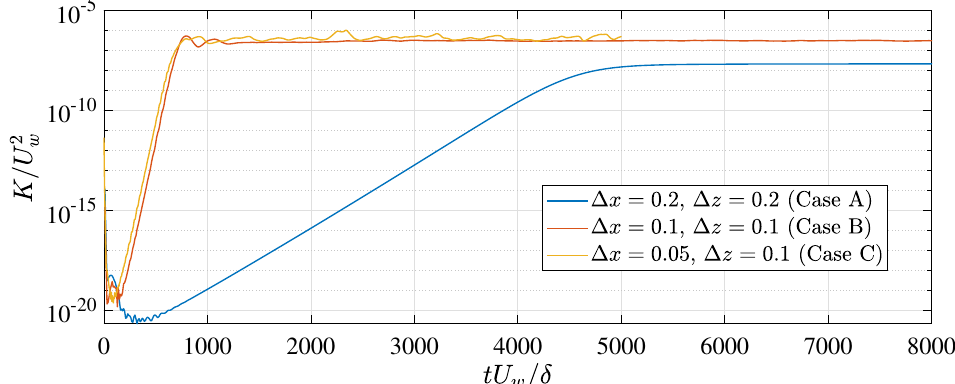
Figure A1. Time series of kinetic energy K whilechanging the grid resolutions for a grid conver- gence